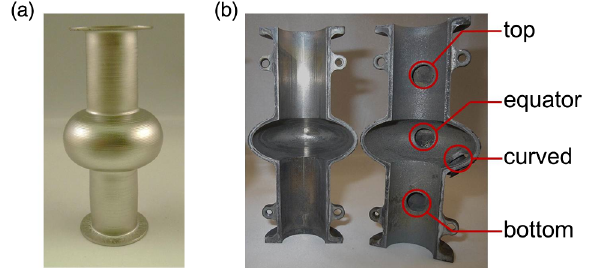
FIG. 2 (color online). (a) 6 GHz Nb cavity provided by Dr. Enzo Palmieri of INFN in Padua, Italy. (b) Stainless steel dummy cavity with similar dimensions to the 6 GHz Nb cavity. Openings at different locations for mounting the substrates are